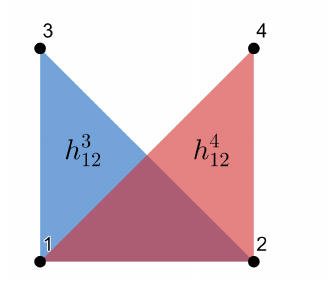
Figure 4. Example